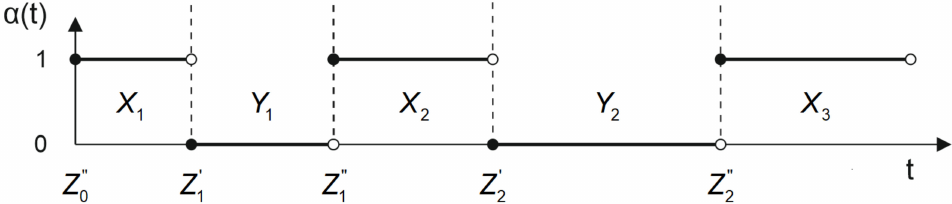
Figure 3. The operational statuses: life (a system’s ability to satisfy the positioning requirements for IHO orders) and failure (an opposite event). Own study based on: